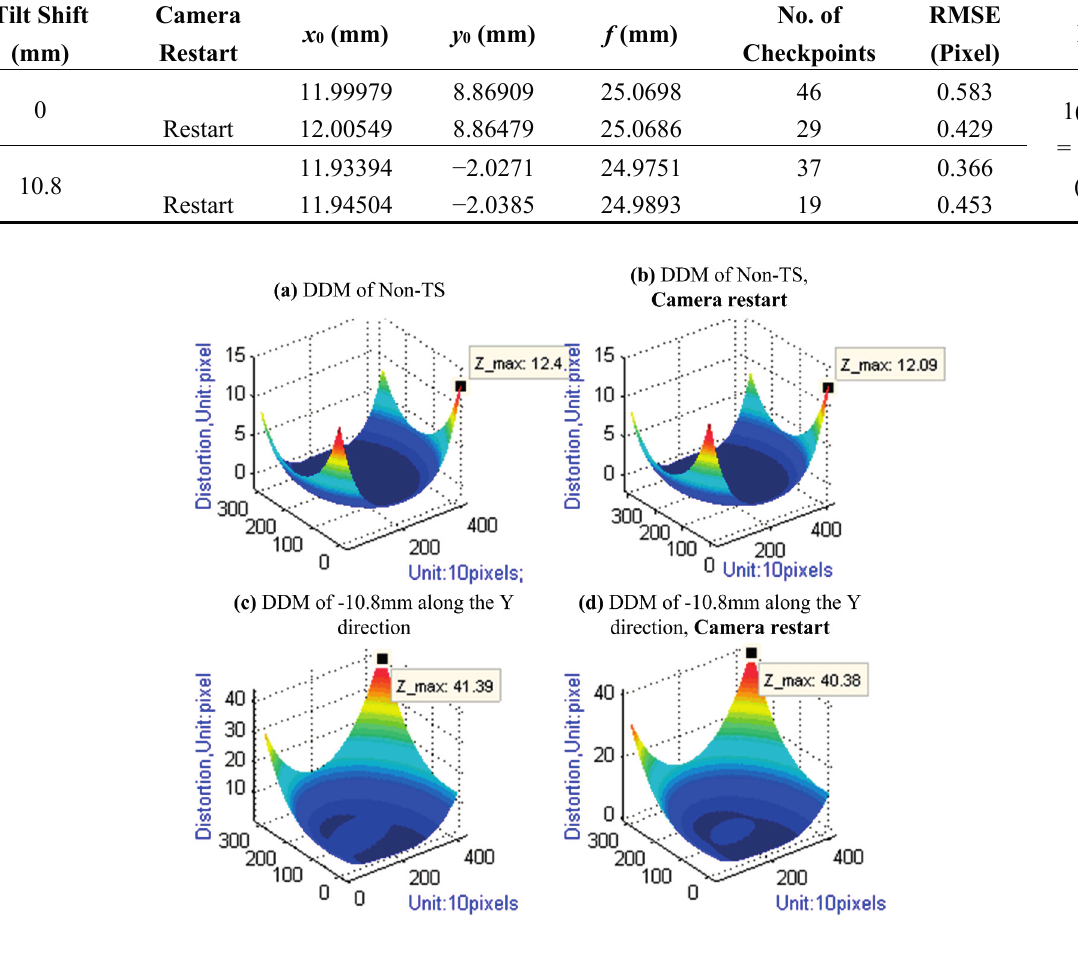
Figure 10. DDM of Camera Restart